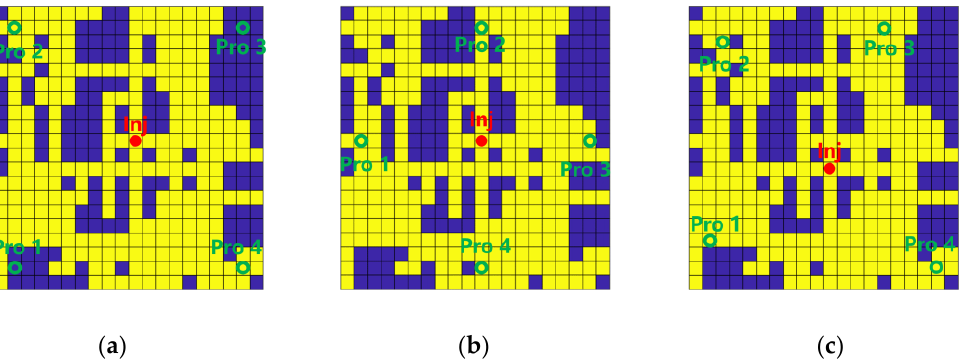
Figure 7. The well-placement of two comparisons and the optimization result (the green circle represents the production well and the red circle represents the injection well): ( a ) Case 1; ( b ) Case 2; ( c ) Case 3.